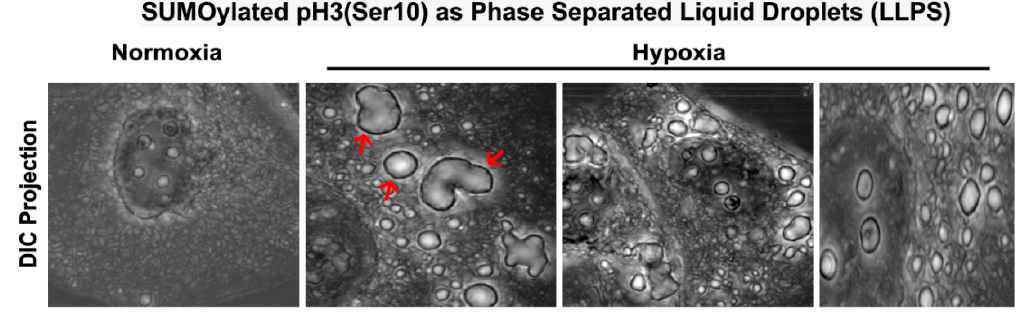
Figure 8. SUMO2-conjugated pH3(Ser10) shows liquid–liquid phase separation (LLPS) in the cytoplasm of tumour cells exposed to acute hypoxia. Cells were subjected to treatment conditions for 96 h. Zoomed images obtained through high-resolution confocal microscopy showed liquid– liquid phase partitioning of SUMO2-pH3(Ser10) in the cytoplasm of hypoxia exposed cells. An example of LLPS is indicated by red arrows in the DIC images and white arrows in the colour images. The LLPS-like regions showed punctate staining of cholesterol around the periphery, indicating that these membraneless aggregates were surrounded by membranous organelles.